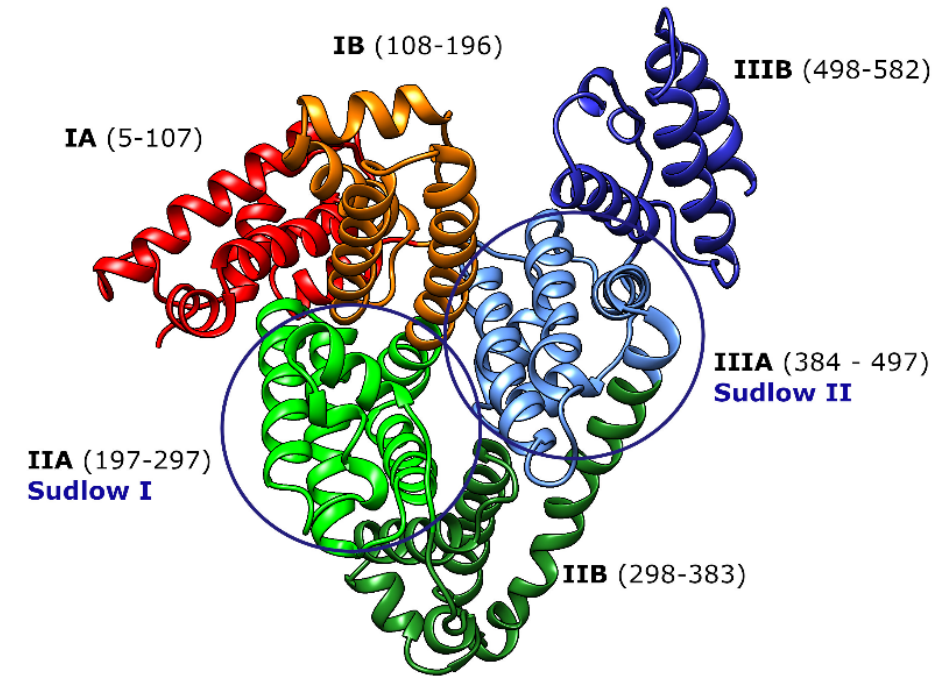
Figure 15. Schematic structure of the molecule of human serum albumin. Sudlow’s sites I and II and domains (with subdomains a and b) are shown. Each subdomain is marked with a different color. The albumin structure was taken from Protein Data Bank (1ha2).